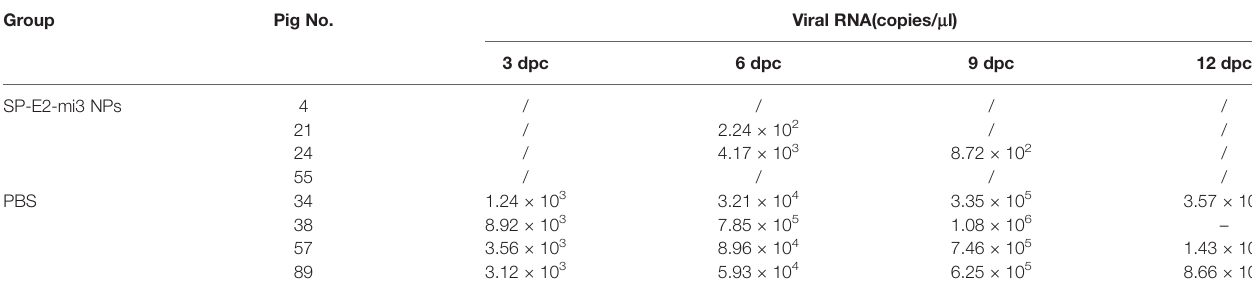
Two groups (n = 4) of 4-week-old piglets immunized with SP-E2-mi3 NPs or PBS were challenged with the highly virulent CSFV Shimen strain. Anticoagulant whole blood samples were collected at 3, 6, 9 and 12 dpc, CSFV RNA loads were detected by qPCR./, undetectable; – ,